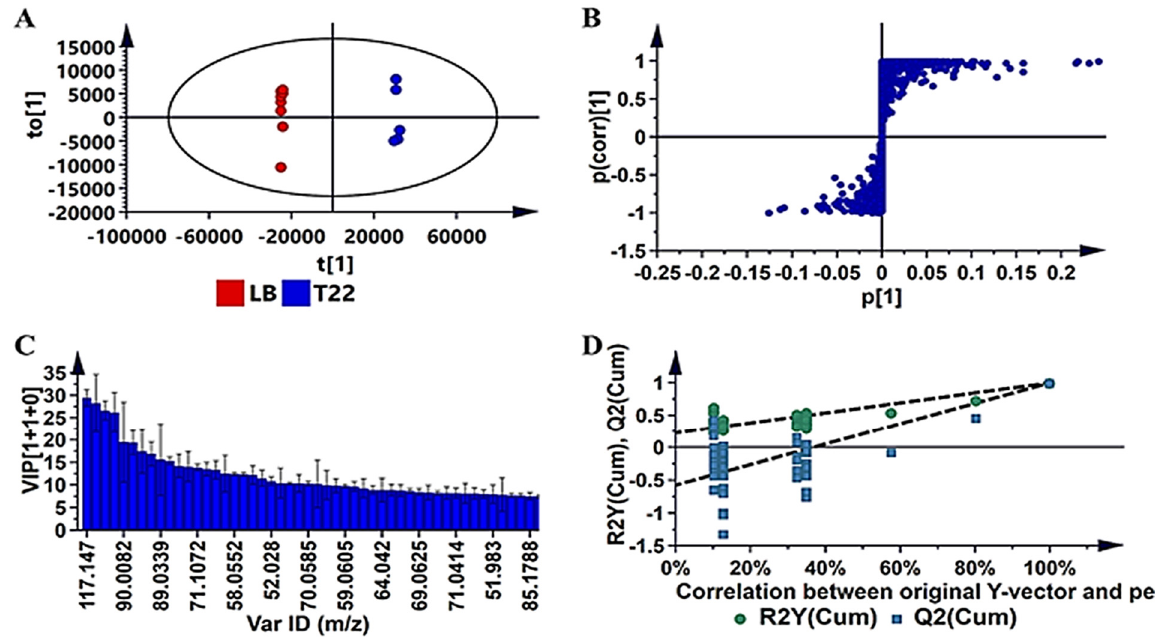
Figure 2. OPLS-DA modeling and variable/feature selection of Lysinibacillus sphaericus (T22) data acquired on GC–TOF–MS . ( A ): A typical OPLS-DA score separating uninoculated media (LB) vs. inoculated media (T22) (1 + 1 + 0 components, R 2 X = 0.895, Q 2 = 0.999, CV-ANOVA p -value = 1.3 × 10 − 13 ). ( B ): An OPLS-DA loadings S-plot for the same model in ( A ); only variables with a correlation [ p ( corr )] of ≥ |0.5| and a covariance of ( p1 ) ≥ |0.05| were chosen as discriminating variables and were identified using the m/z to generate elemental composition. ( C ): A variable importance for the projection (VIP) plot for the same model, pointing mathematically to the importance of each variable in contributing to group separation in the OPLS-DA model. ( D ): The response permutation test plot (n = 50) for the same OPLS-DA model: R 2 (0.0, 0.207) and Q 2 (0.0 − 0.739) values of the permuted models are represented on the left-hand side of the plot, corresponding to y -axis intercepts. Similar